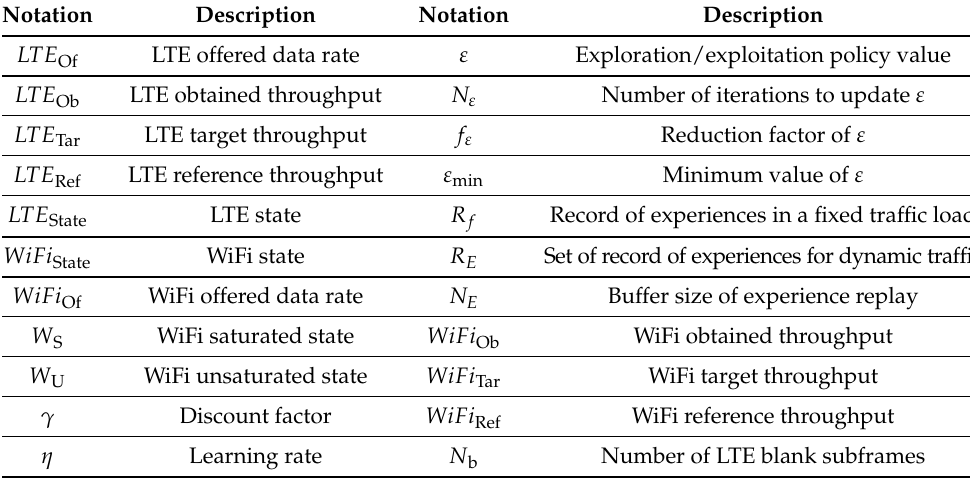
Table 1. Summary of notations